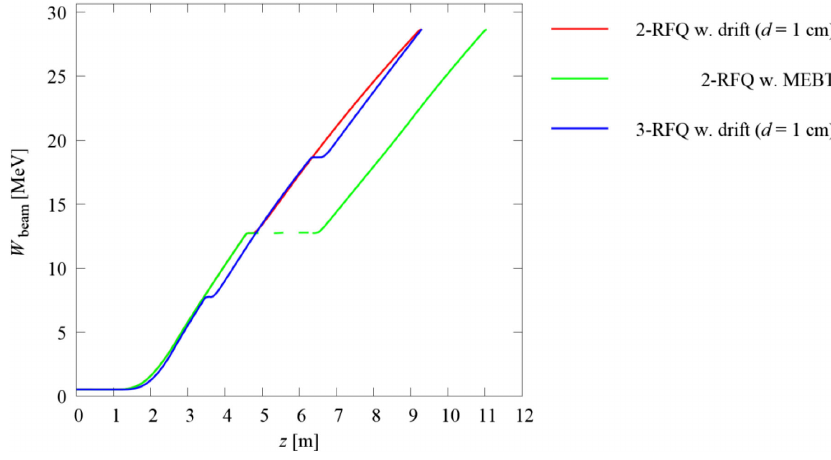
FIG. 16. Evolution of the synchronous energy for the three reference cases.